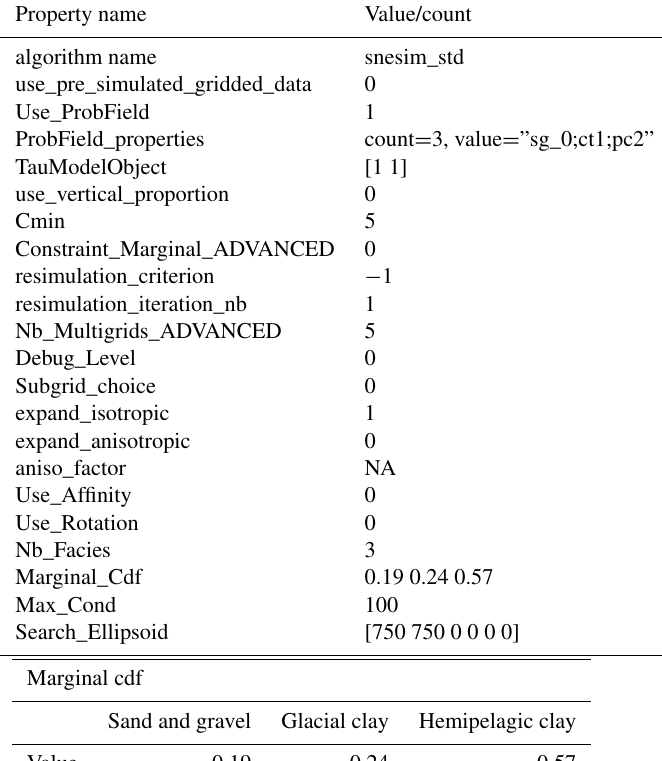
Table A2. General SGeMS parameters used for the snesim realiza-